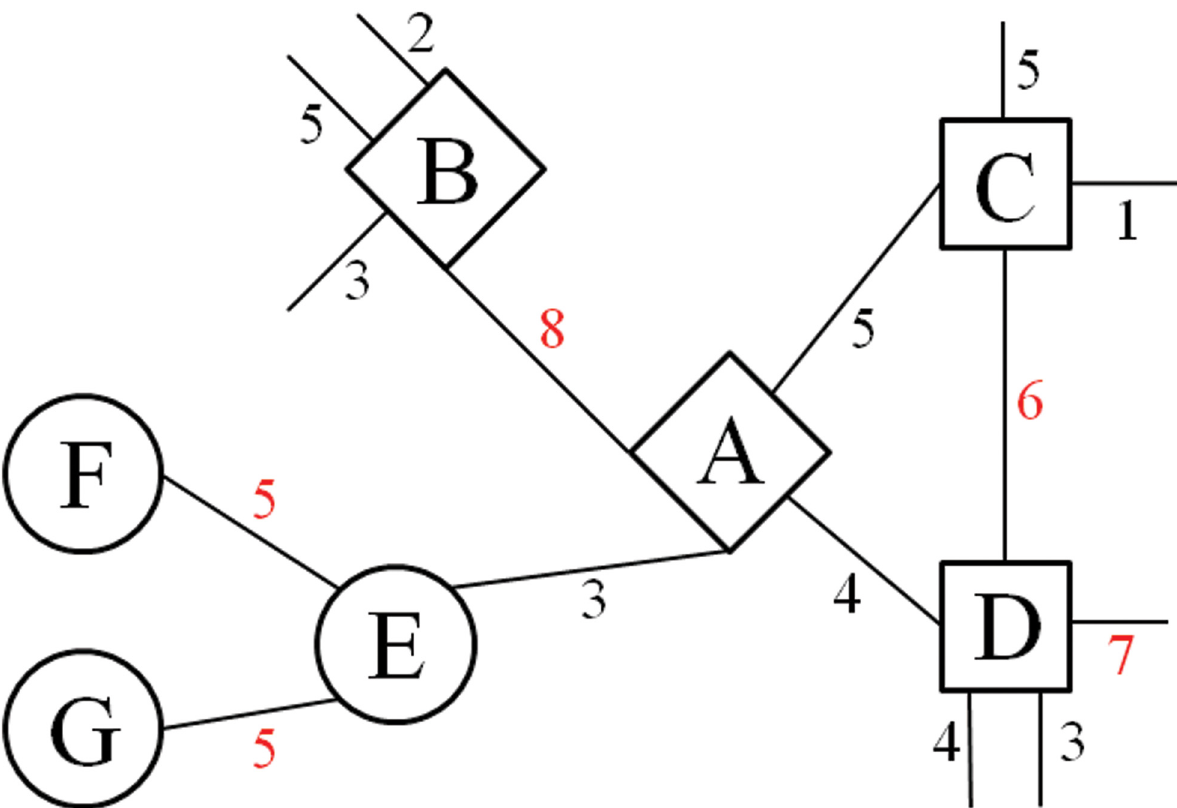
Fig 2. Example of a MNS grouping. Nodes A to G are divided into 3 groups (diamond, square and circle). The numbers attached to the edges are the MNS of a pair of nodes. Numbers in red indicates the highest MNS with another node. It must be noted that not all possible related nodes and edges are depicted in this